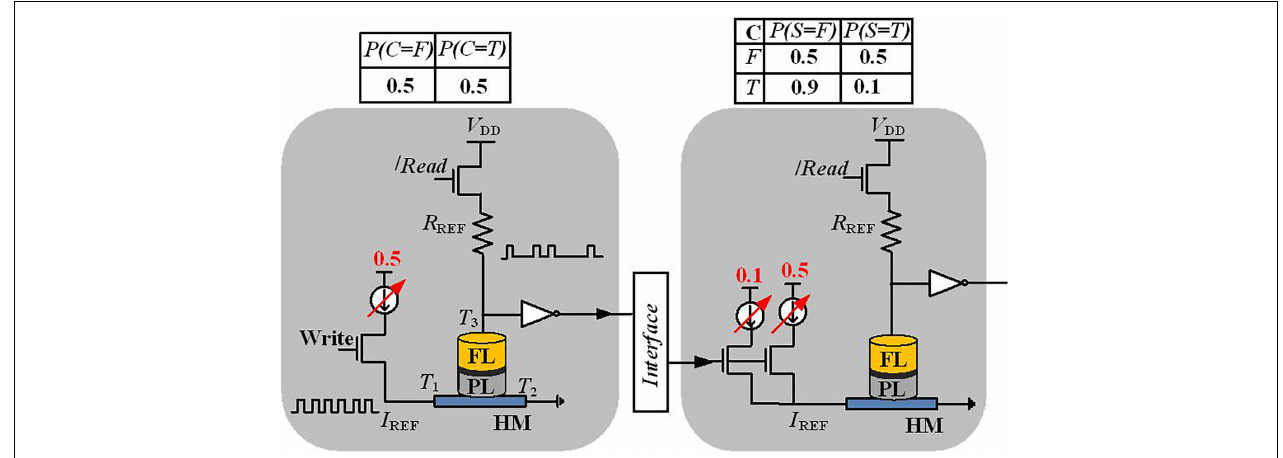
FIGURE 3 | Detailed implementation view of a Bayesian network variable and the interconnection between the two nodes C and S in the four-node Bayesian network of Figure 1